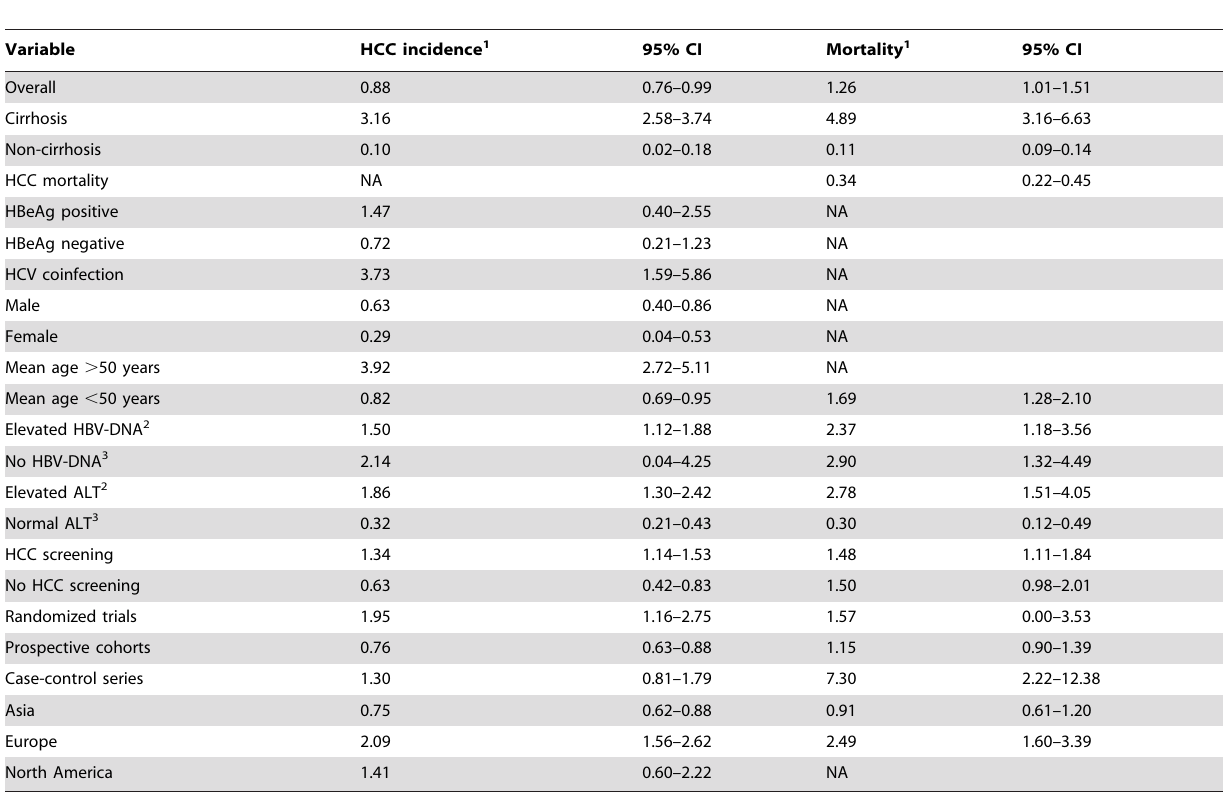
Table 2. Annual Hepatocellular Carcinoma Incidence and Mortality Rates in Chronic Hepatitis B